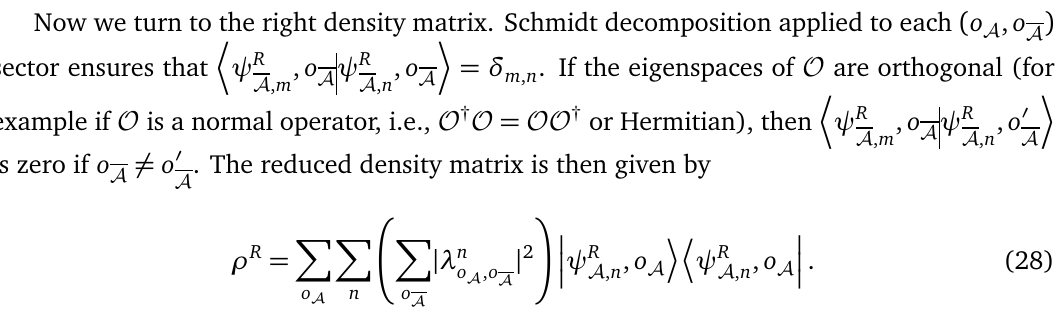
Figure 1: Three different types of band structure for non-Hermitian two-level sys- tems. In (a) the band structure is non-separable while still having a point gap. It is a fundamentally non-Hermitian structure, which admits both purely imaginary and real energies. Only (b) and (c) have well-defined line gap. This line gap can be the imaginary (b) or the real (c) axis, which relates naturally to a Hermitian (b) or an anti-Hermitian (c) limit. Purely imaginary (real) energies are then